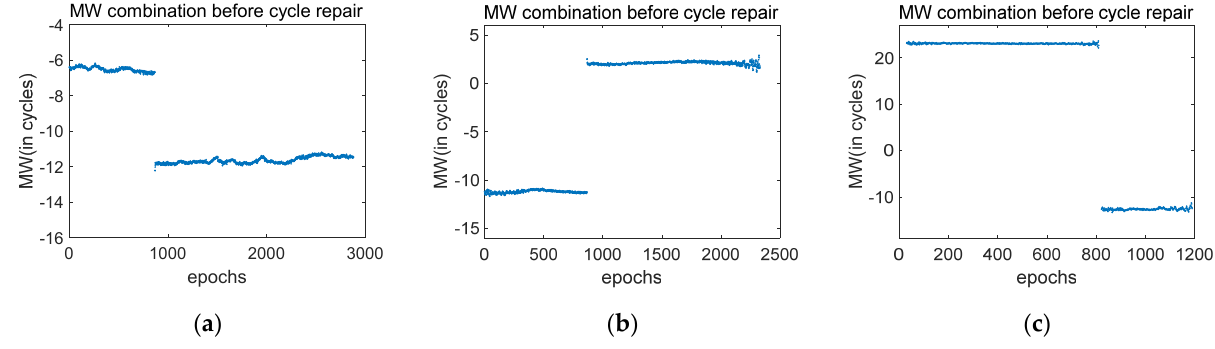
Figure 3. MW combination values before cycle slips were repaired.